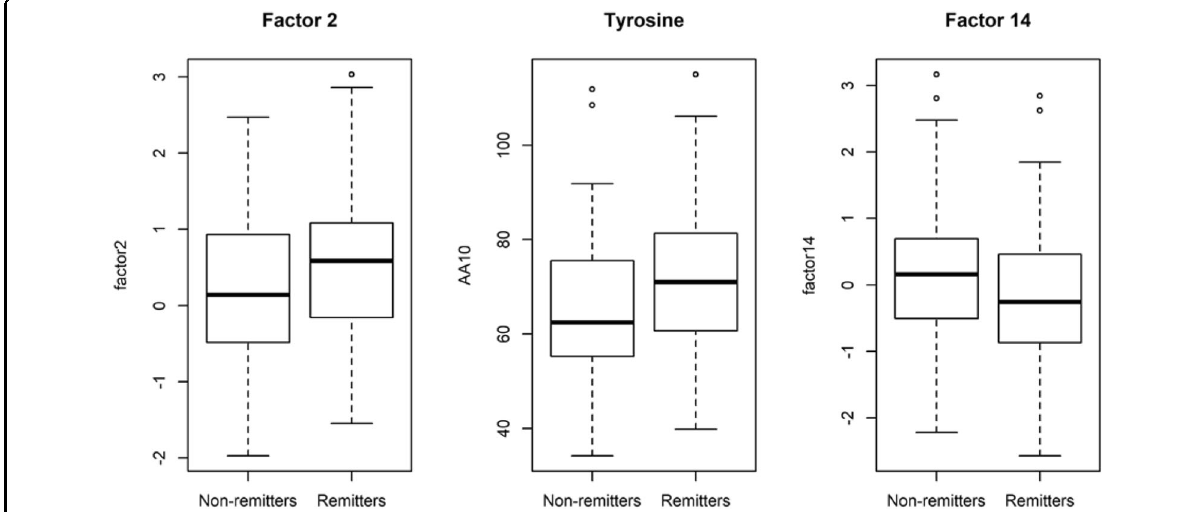
Fig. 1 Pre-intervention levels of signi fi cant factors. Factor 2 (BCAA, tyrosine, phenylalanine, methionine, arginine and histidine), factors 14 (betaine and choline) and tyrosine in individual with (remitters) or without (non-remitters) remission of type 2 diabetes after weight loss